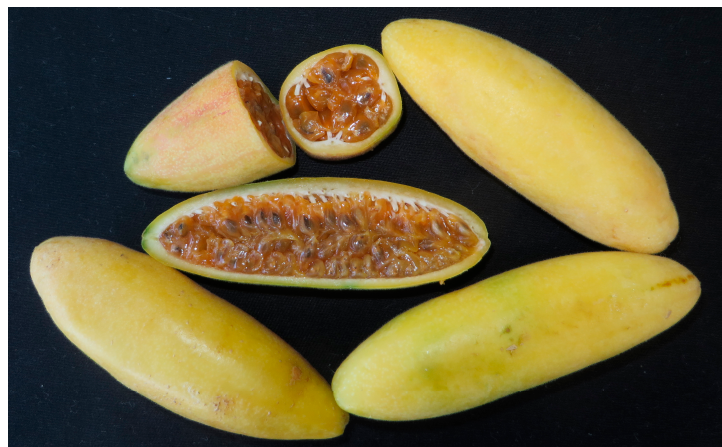
Figure 1. The fruit of banana passion fruit ( Passiflora mollissima (Kunth) L.H.Bailey). P. mollissima is a source of vitamins, calcium, iron, phosphorus, potassium, and fiber [6]. In